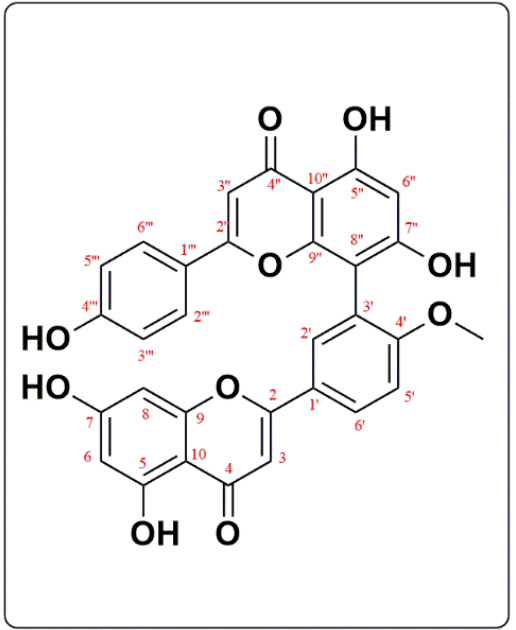
Figure 1. Chemical structure of Compound I (Bilobetin or 4’- O -methyl amentoflavone). Table 1. 1 H-NMR and 13 C-NMR (DMSO- d 6 , 500, and125 MHz) for